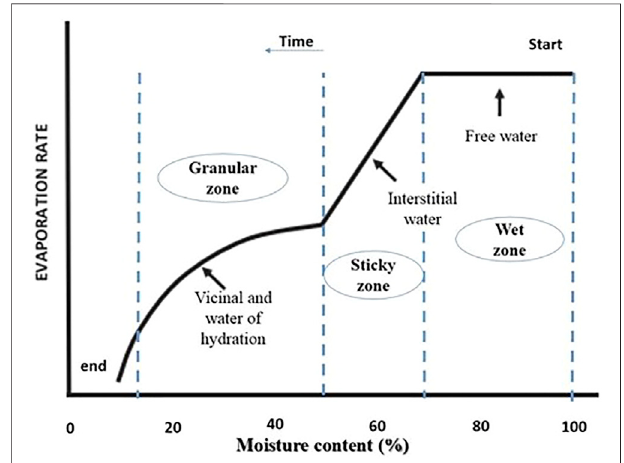
FIGURE 2 | Drying behavior of sewage sludge obtained from drying experiments (adapted from Lowe (1995).